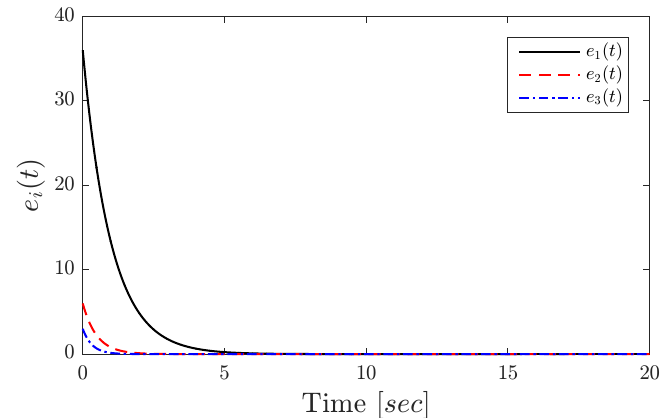
Figure 4. Time evolution of the synchronization error for the 3D case.